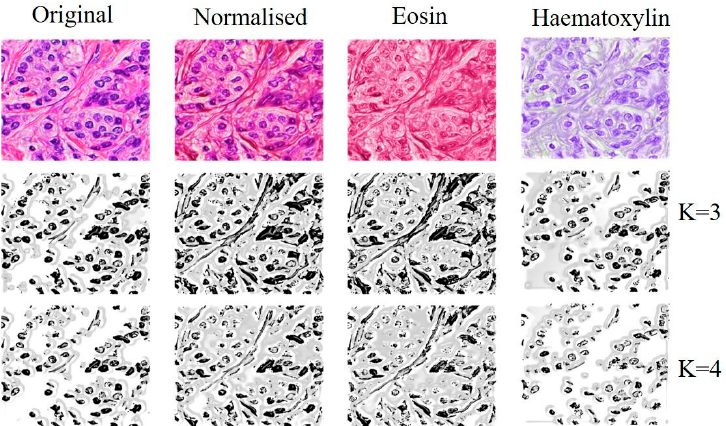
Figure 4. Segmentation using the K-means algorithm with k = 3 and k = 4.